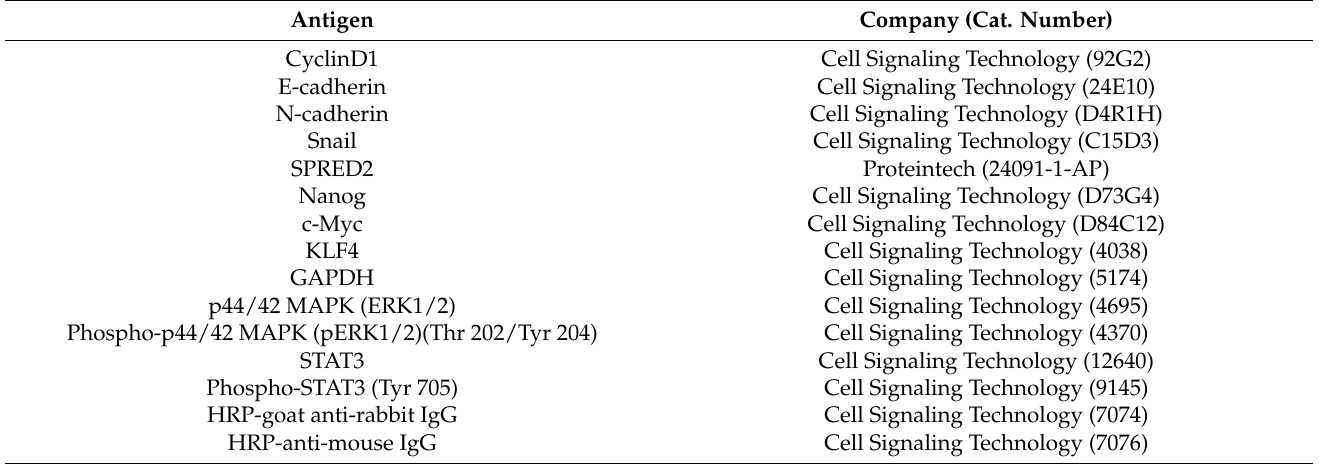
Table 3. Antibodies for Western blotting and